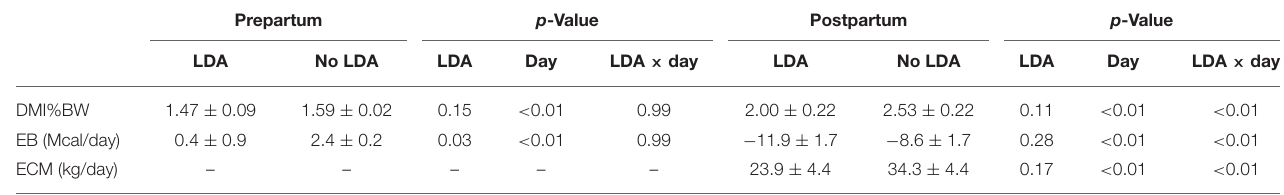
TABLE 2 | Association of pre- ( − 21 to − 1 day) and postpartum (1 to 28 days) dry matter intake as percentage of body weight (DMI%BW), energy balance (EB), and energy-corrected milk (ECM) with left displaced abomasum (LDA) postpartum according to multivariable analysis.